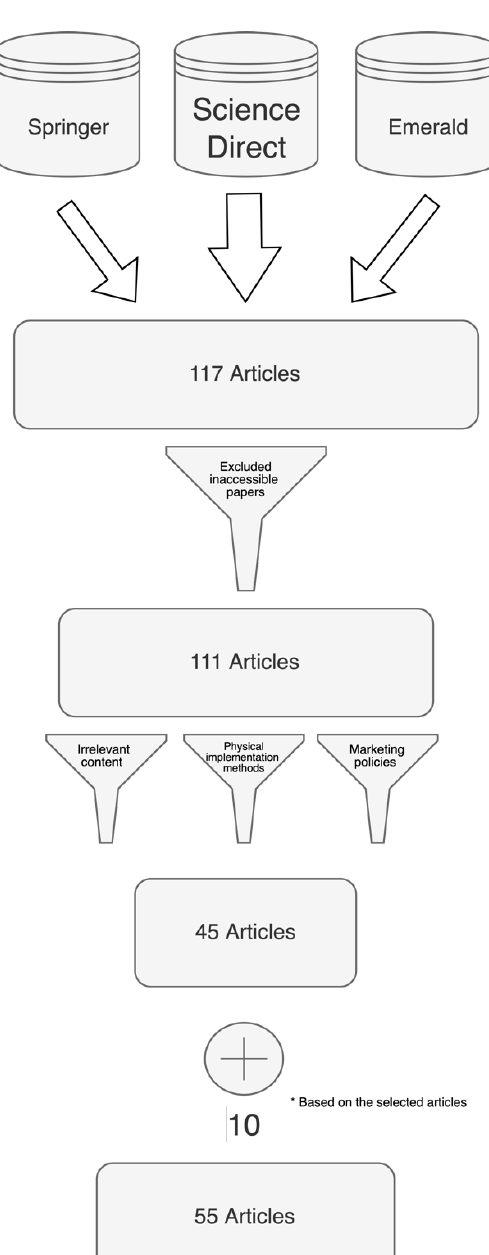
Figure 2. The systematic survey process.